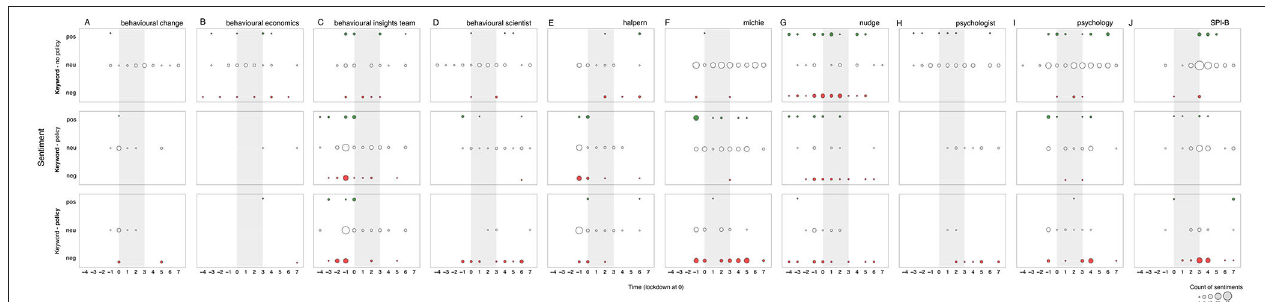
FIGURE 6 | Sentiment toward the 10 primary keywords separated by sentences that do (top row) and do not refer to public policy application (middle row), and sentiment toward policy actors of keywords (bottom row) over a 12 two-week time period surrounding the first British national lockdown of 2020 in newspaper articles. Sentiments are represented in counts of positive ( + 1 or + 2), neutral (0), and negative ( − 2 or − 1) bubbles over time, in green, white and red respectively. The area of the bubbles is proportional to the count of sentiments toward the keyword. Reference category in bold. Column (A) behaviour change (concept), (B)